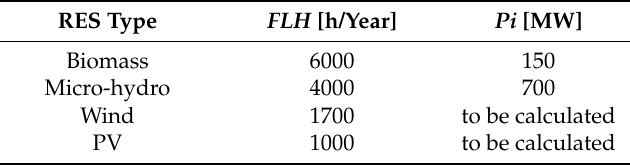
Table 7. FLH and Pi in case of best scenario.